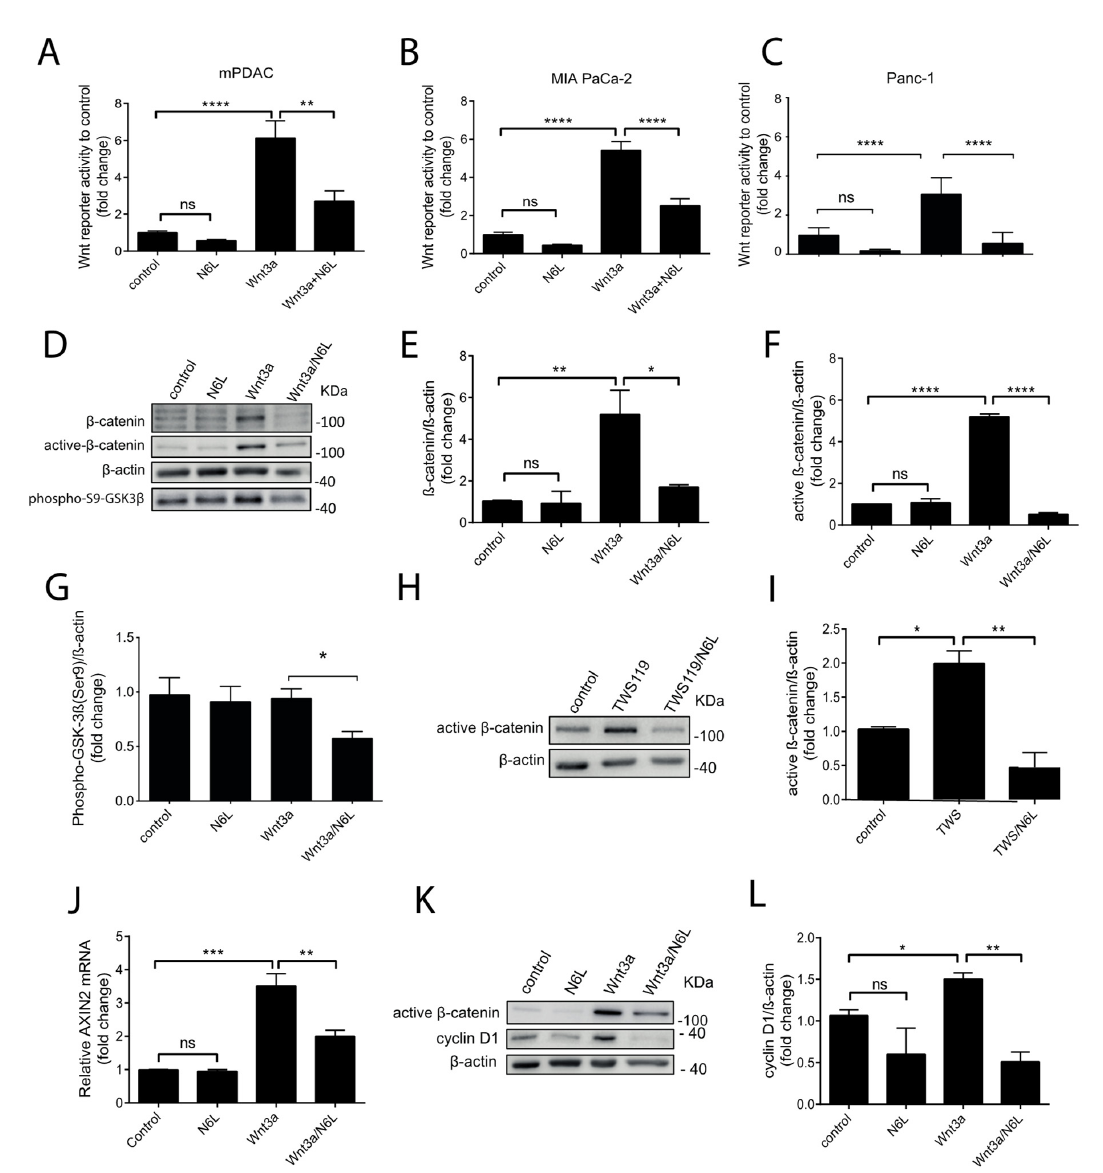
Figure 2. N6L inhibits β -catenin activation. ( A – C ) mPDACs, MIA PaCa-2 and Panc-1 cells were transfected with Firely luciferase Wnt reporter and Renilla luciferase for control and stimulated with Wnt3a-CM in presence or absence of N6L for 24 h. Graphs show the fold change of the ratio of Firefly/Renilla luciferases activity (Dual-Luciferase Reporter Assay). Wnt3A-CM induced a significant increase of luciferase activity that was inhibited in presence of 30 μ M N6L in all cell lines. (One-way ANOVA, multiple comparison, n = 3 experiments, **** p < 0.001). ( D – G ) Western blotting of active, total β -catenin and phospho-Ser9-GSK3 β of MIA PaCa-2 cells treated for 3 h with N6L and Wnt3a-CM and relative quantification are shown. Active β -catenin was analyzed by using an antibody against non-phosphorylated form of β -catenin. In ( E–G ) (One way ANOVA, multiple comparison, n = 5, ns = non-significant, * p < 0.05, ** p < 0.01, **** p < 0.0001). ( H , I ) Western blotting and relative quantification of active β -catenin level of MIA PaCa-2 cells treated for 30 minutes with 10 μ M TWS119 alone or with 30 μ M N6L (One-way ANOVA, multiple comparison, n = 3, * p < 0.05, ** p < 0.01). ( J ) qPCR analysis of AXIN2 mRNA and ( K , L ) Cyclin D1 protein level analysis by Western blotting after 24 h of N6L treatment in presence of Wnt3A-CM compared to Wnt3a-CM alone. (One-way ANOVA, multiple comparison, n = 3, ns = non-significant, * p < 0.05, ** p < 0.01, *** p <